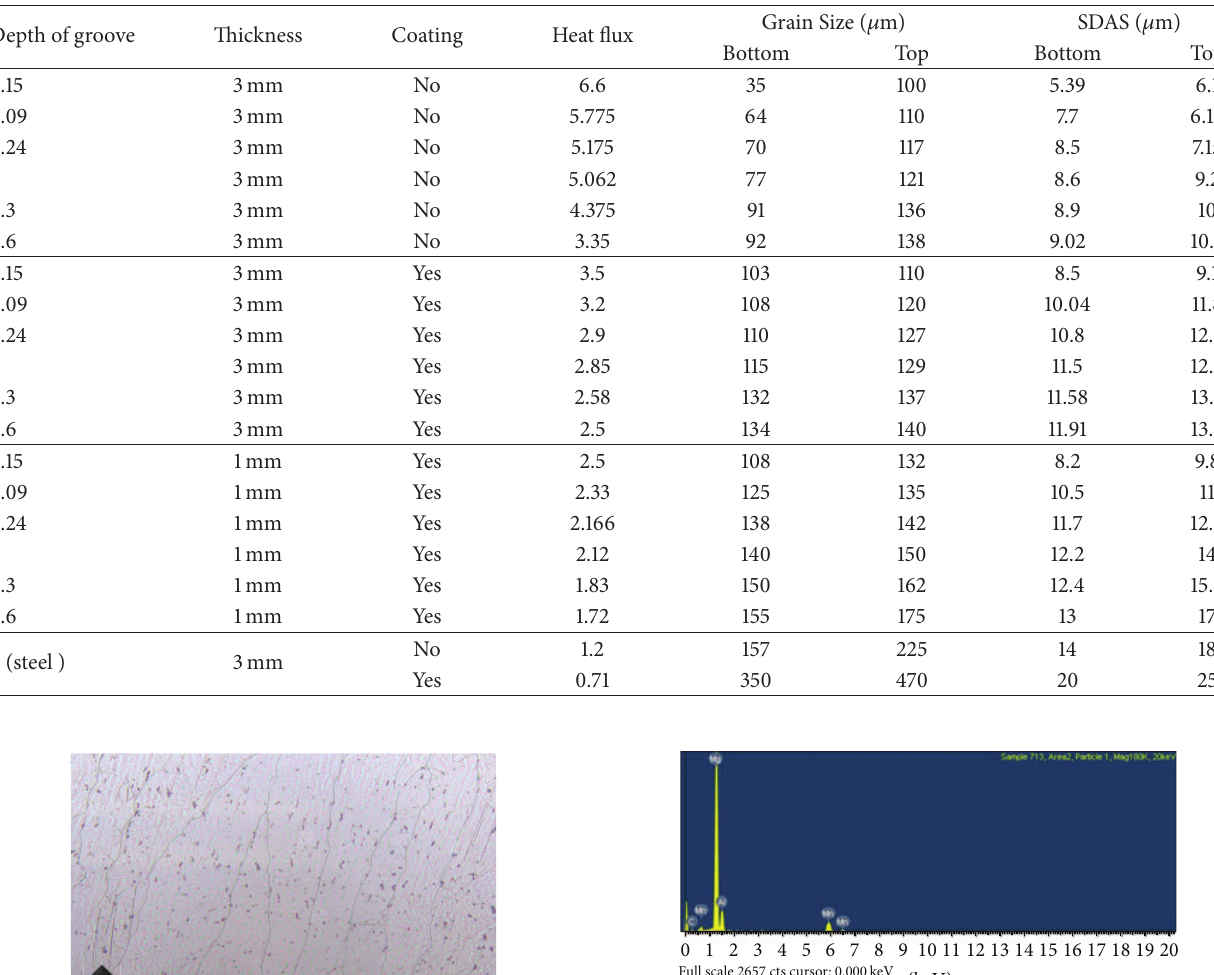
Table 5: Microstructure analyses of strips.